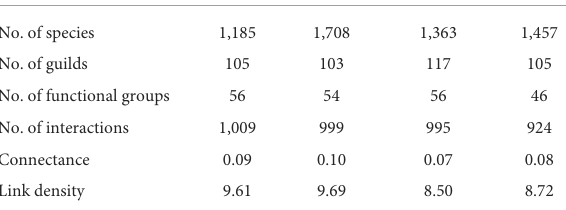
TABLE 1 Summary of guild-level food web network measures representing Anisian, Carnian, Bathonian, and Aptian communities. Network parameter Anisian Carnian Bathonian Aptian